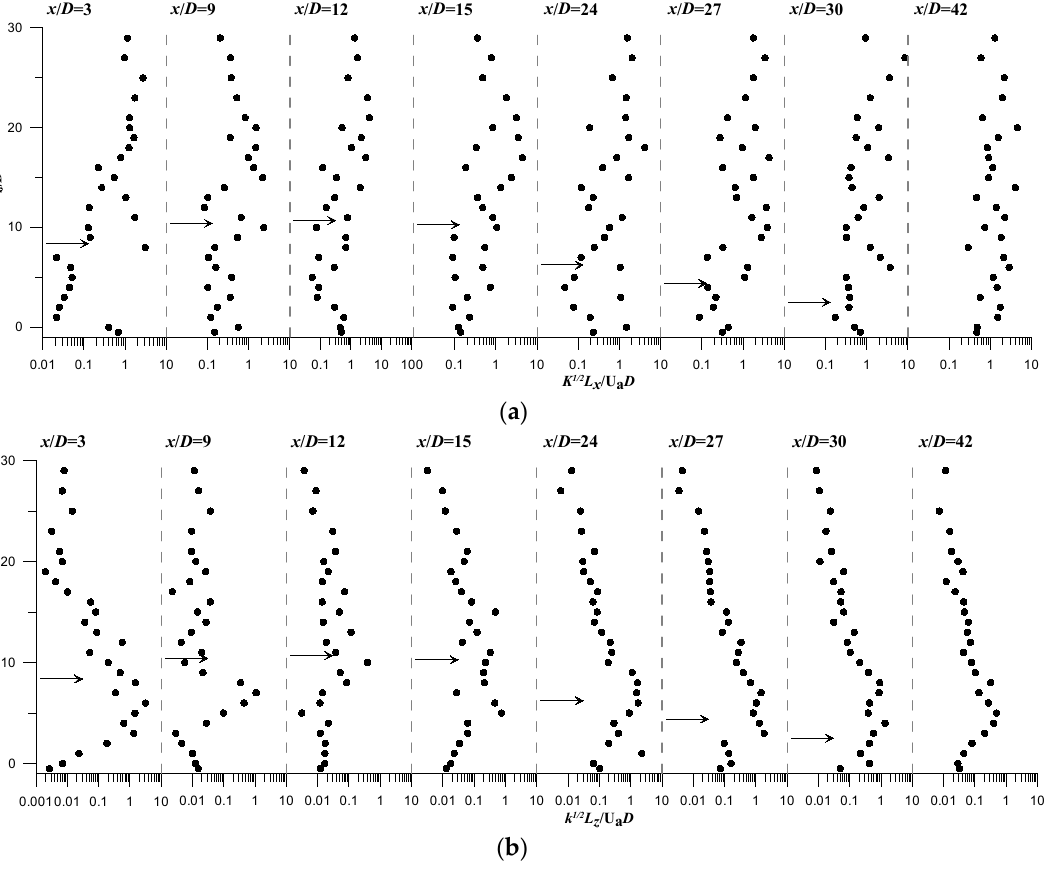
Figure 15. Trend of the turbulent dispersion coefficient K x and K z at different downstream positions x / D at the plane of flow symmetry ( y = 0) of run R1: ( a ) k x ~ k ½ L x / U a D ; ( b ) k z ~ k ½ L z / U a D . The horizontal arrow on the profiles indicate the position of the jet axis.